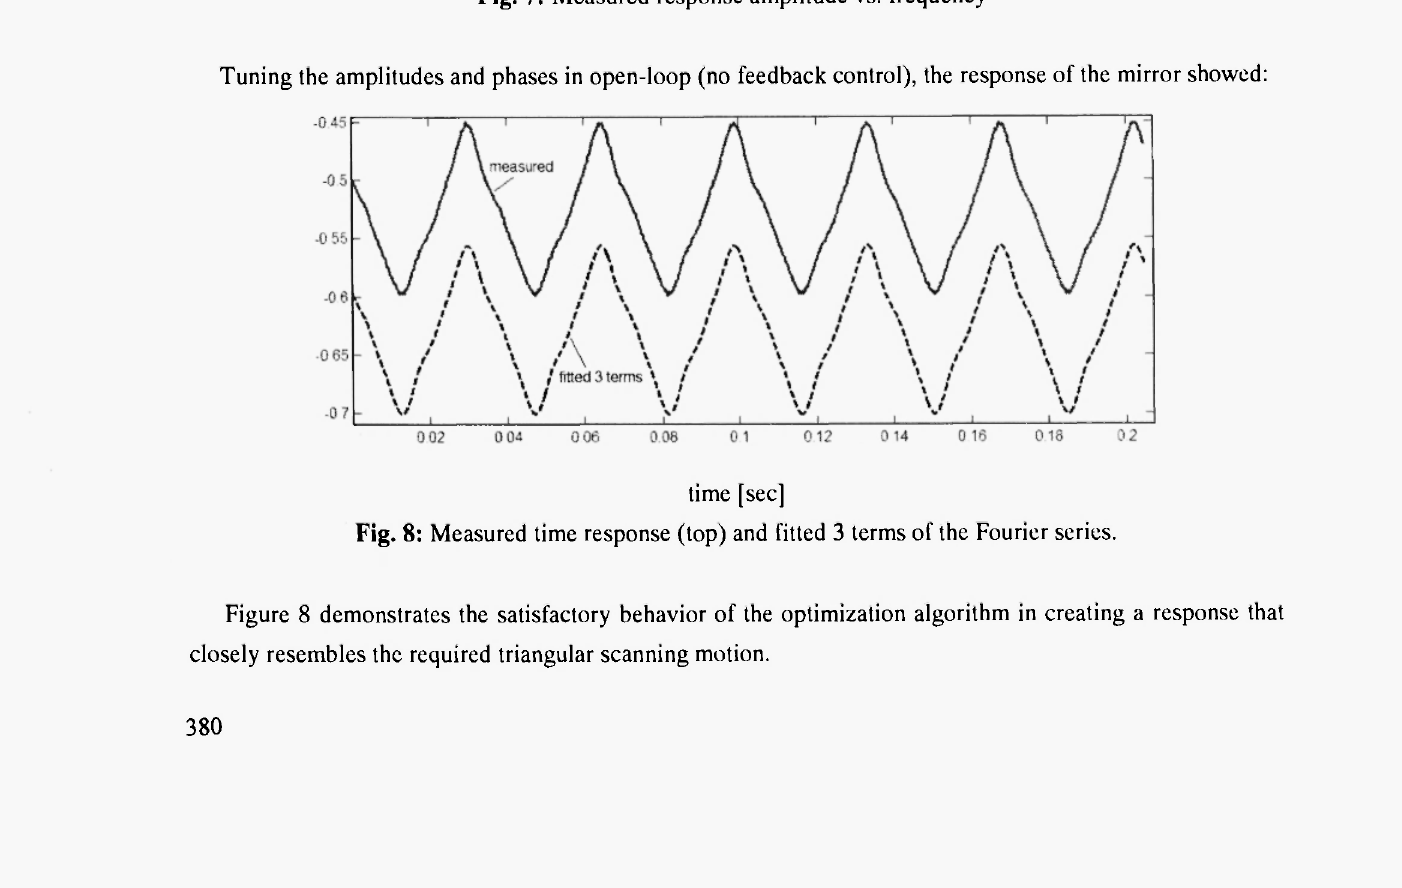
Fig. 7: Measured response amplitude vs. frequency